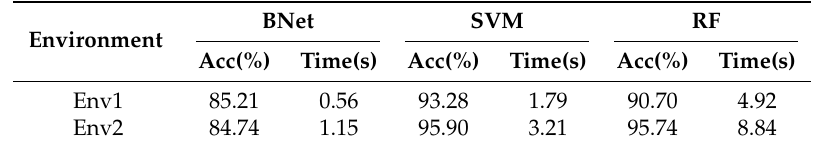
Table 1. Performance and training time for machine learning algorithms.